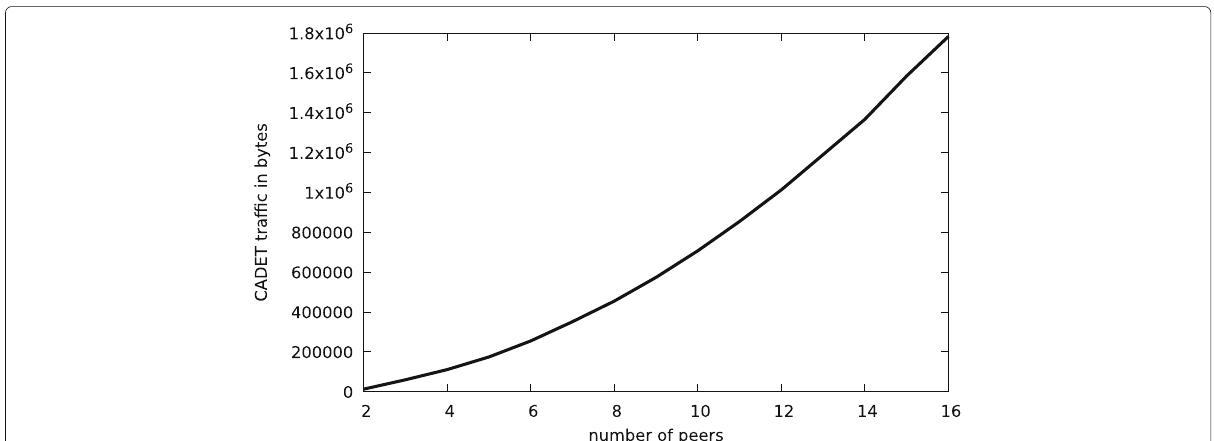
Fig. 6 CADET traffic for BSC per peer for 100 elements and only correct peers. Average over 50 executions